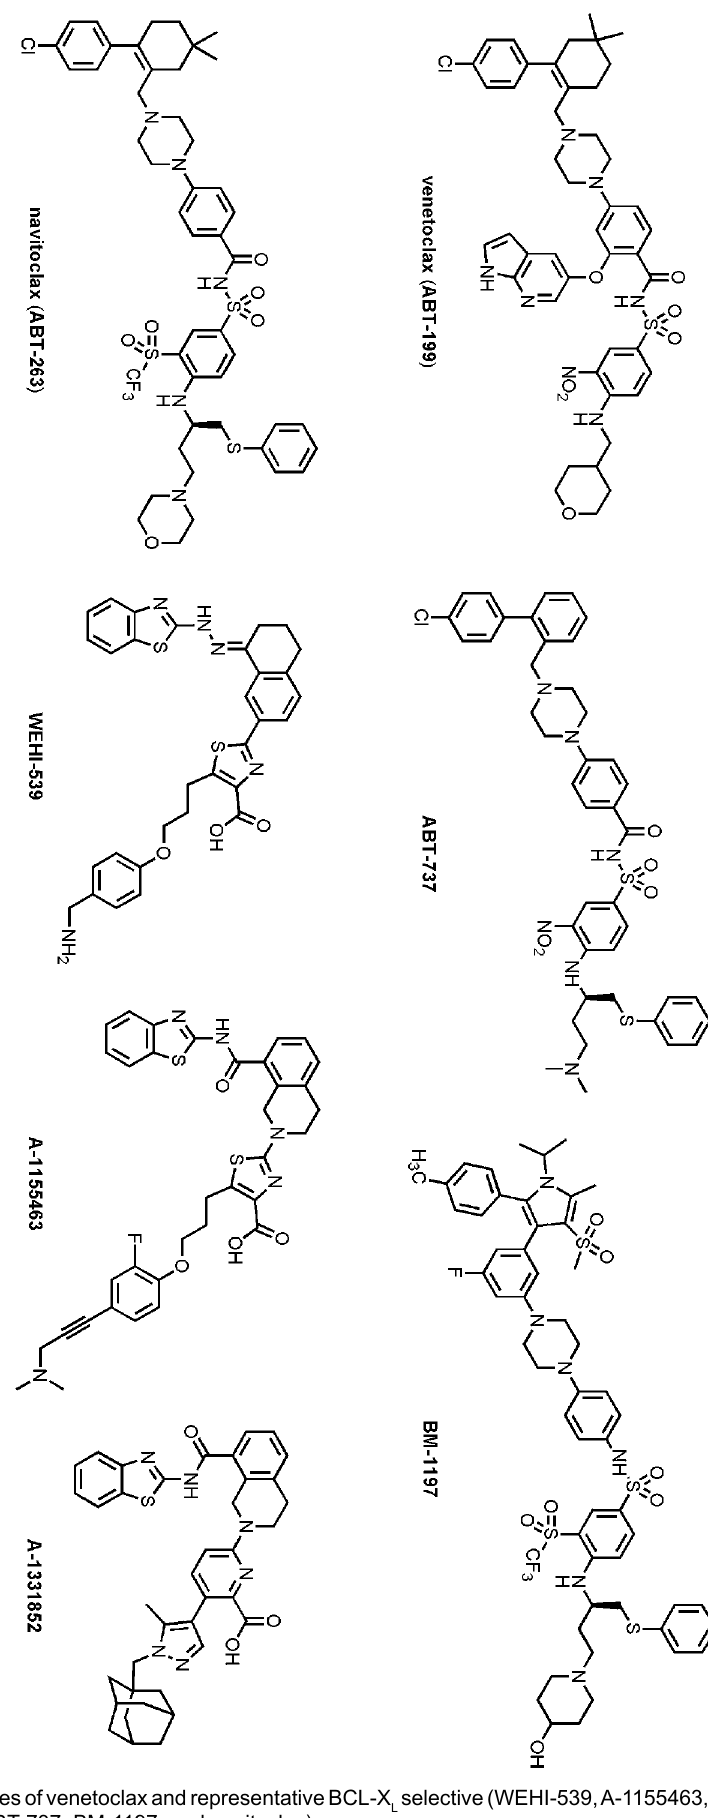
Figure 2. Structures of venetoclax and representative BCL-X dual inhibitors (ABT-737, BM-1197, and